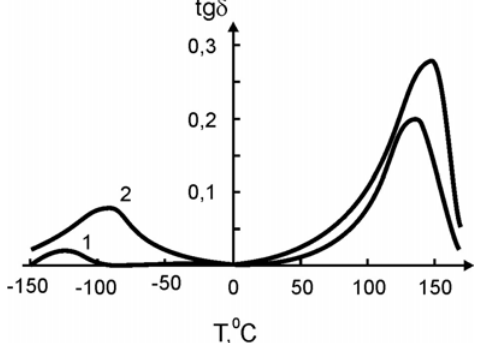
Figure 12. Temperature dependence of tg δ for the pure SHMPE and for the